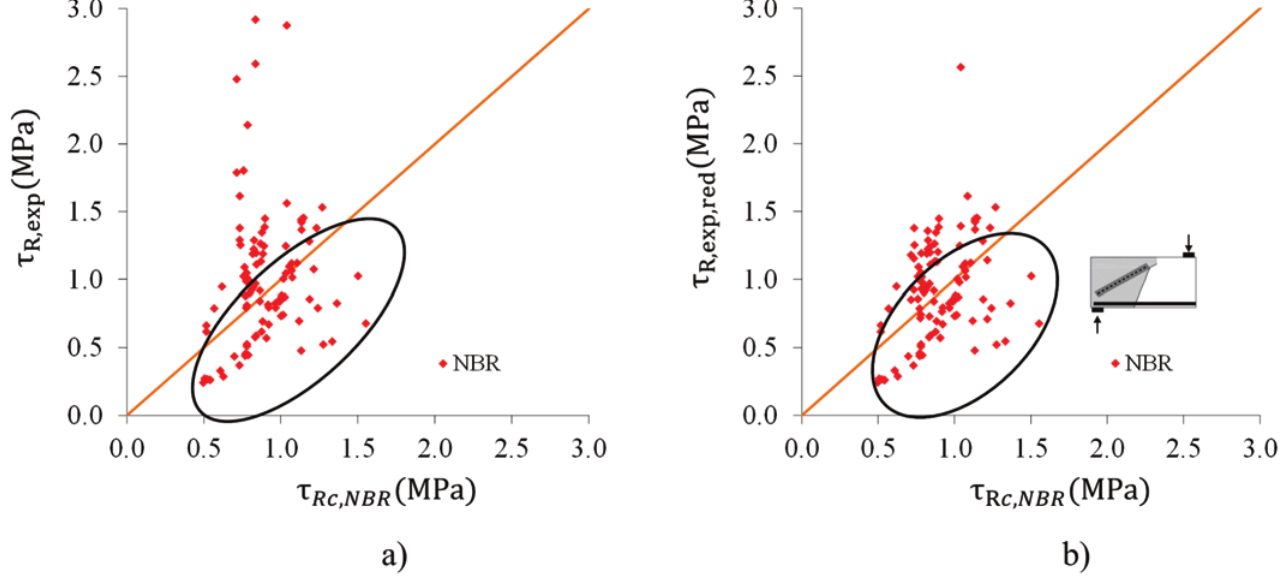
Evaluation of the punching capacity model according to ABNT NBR 6118:2014 ( γ a) Without β and b) With β EC